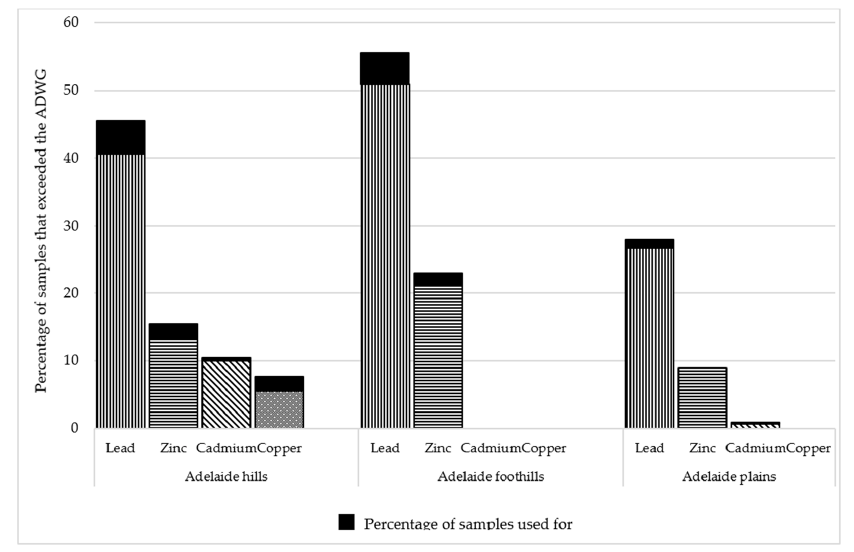
Figure 2. The percentage of total samples and samples used for drinking above the ADWG for each sampling location.